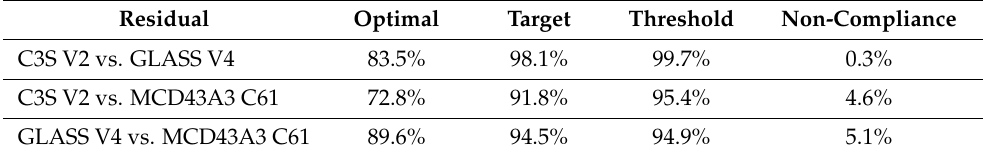
Figure 6. Temporal evolution of the percentage of LANDVAL missing data in the 2003 for C3S V2 (red), GLASS V4 (green), and MCD43A3 C6.1 (blue) considering all pixels ( top ), and only best quality pixels ( bottom ) according to quality flags. Table 7. Percentage of mean residuals between pair of products (C3S V2, GLASS V4 and MCD43A3 C6.1) within each level of uncertainty requirements. Evaluation in the 2001–2005 period over LAND- VAL sites using best quality total shortwave black-sky albedo (AL-DH-BB)